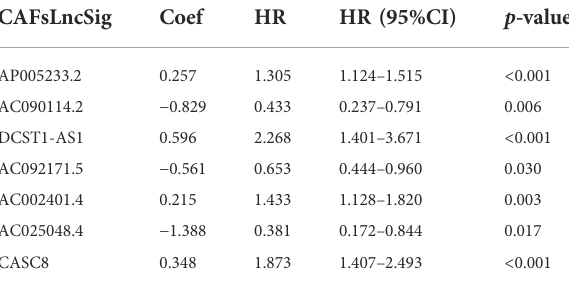
TABLE 2 Long non-coding RNA signature models associated with